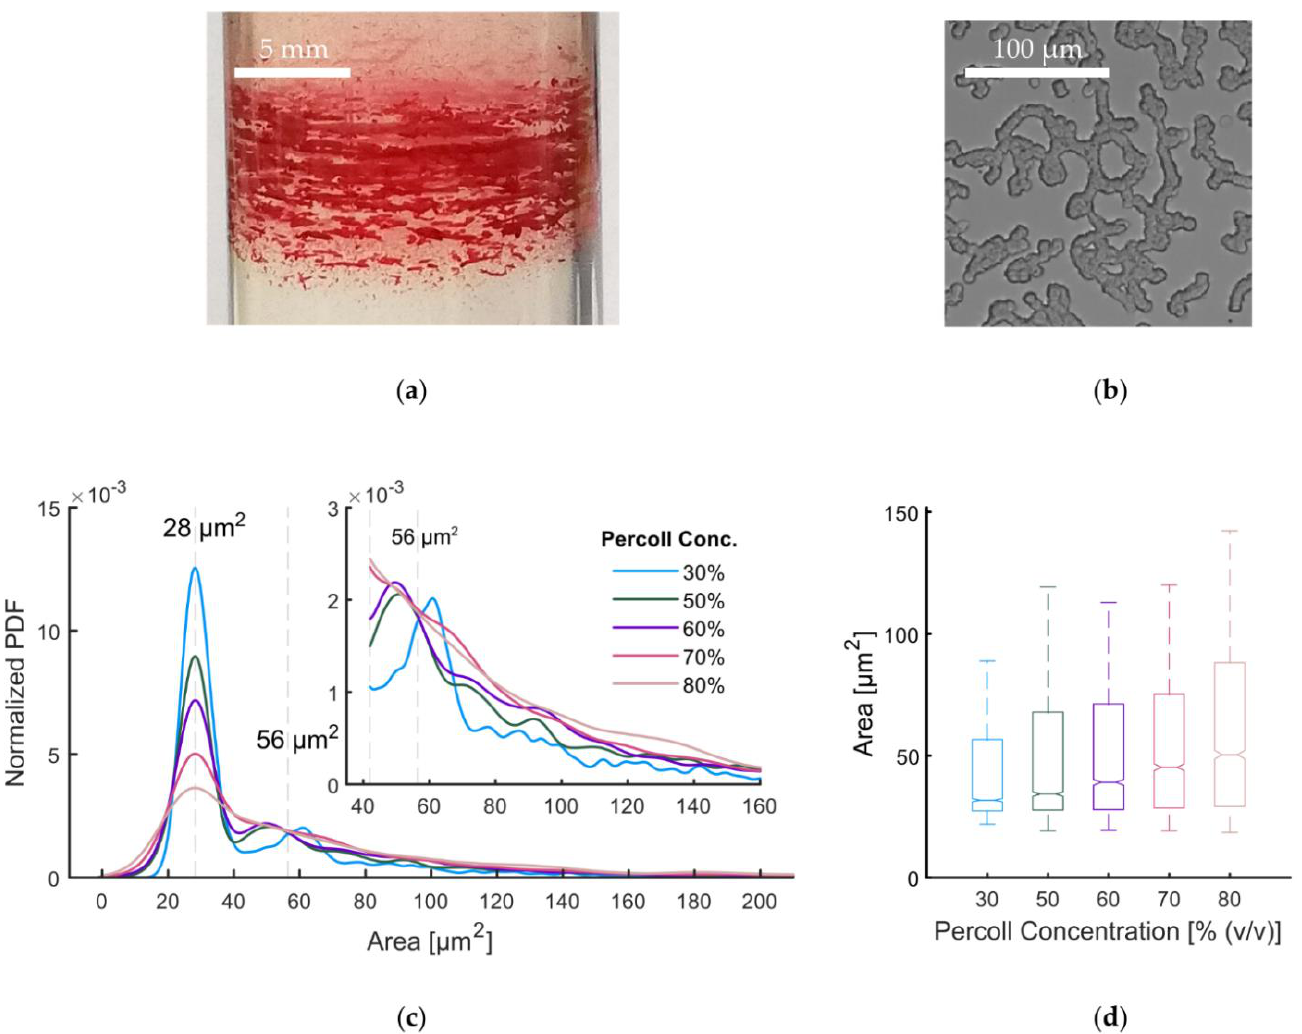
Figure 5. Aggregation of RBCs in a Percoll medium: ( a ) macroscopic aggregates in the band pattern after centrifugation; ( b ) Rouleaux formation of RBCs extracted from a gradient under the microscope; ( c ) distributions of the projection area as measured from microscopic images for different Percoll concentrations; ( d ) boxplots of the distributions in ( c ), edges show quartiles, whiskers the 2.5th and 90th percentiles, notches the estimated 95% confidence interval.